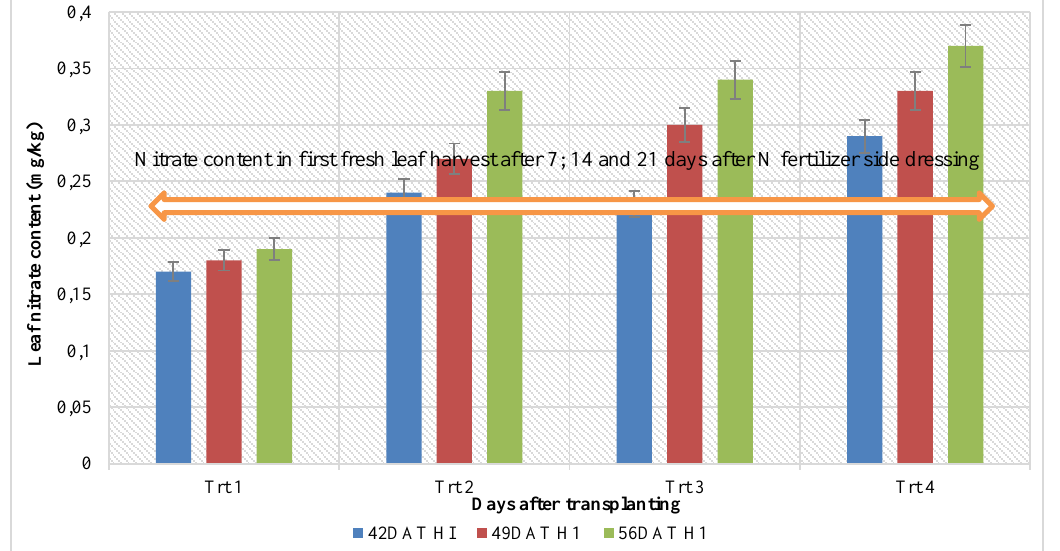
Figure 7a. Leaf nitrate content in first harvest rape leaf after N side dressing